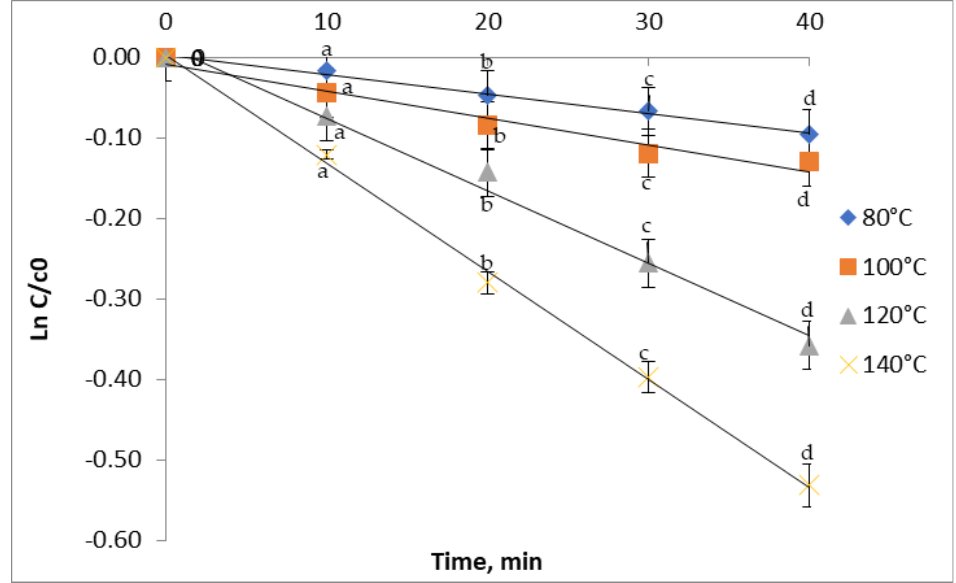
Figure 3. Isothermal degradation of TFC in red grape skin extract treated at different temperatures.